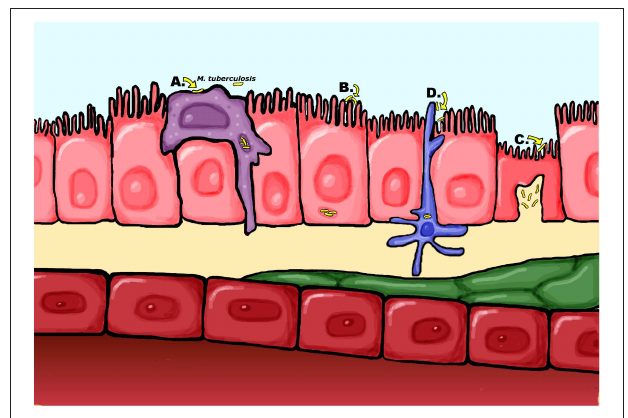
FIGURE 2 | Proposed mechanisms of M. tuberculosis dissemination across the airway epithelia (A) The “trojan horse” model of dissemination where M. tuberculosis is carried across the epithelial barrier within infected macrophages. (B) M. tuberculosis is capable of directly infecting epithelial cells, which could result in bacteria translocating across the barrier through the epithelial cells or inducing cell death to cause a breach in the barrier (C) Passage across the epithelium may occur in specialized M cells which actively translocate antigens to the interstitium for presentation to antigen presenting cells (D) Alternatively, dendritic cells sampling antigens in the alveoli may traffic live mycobacteria to the lymph